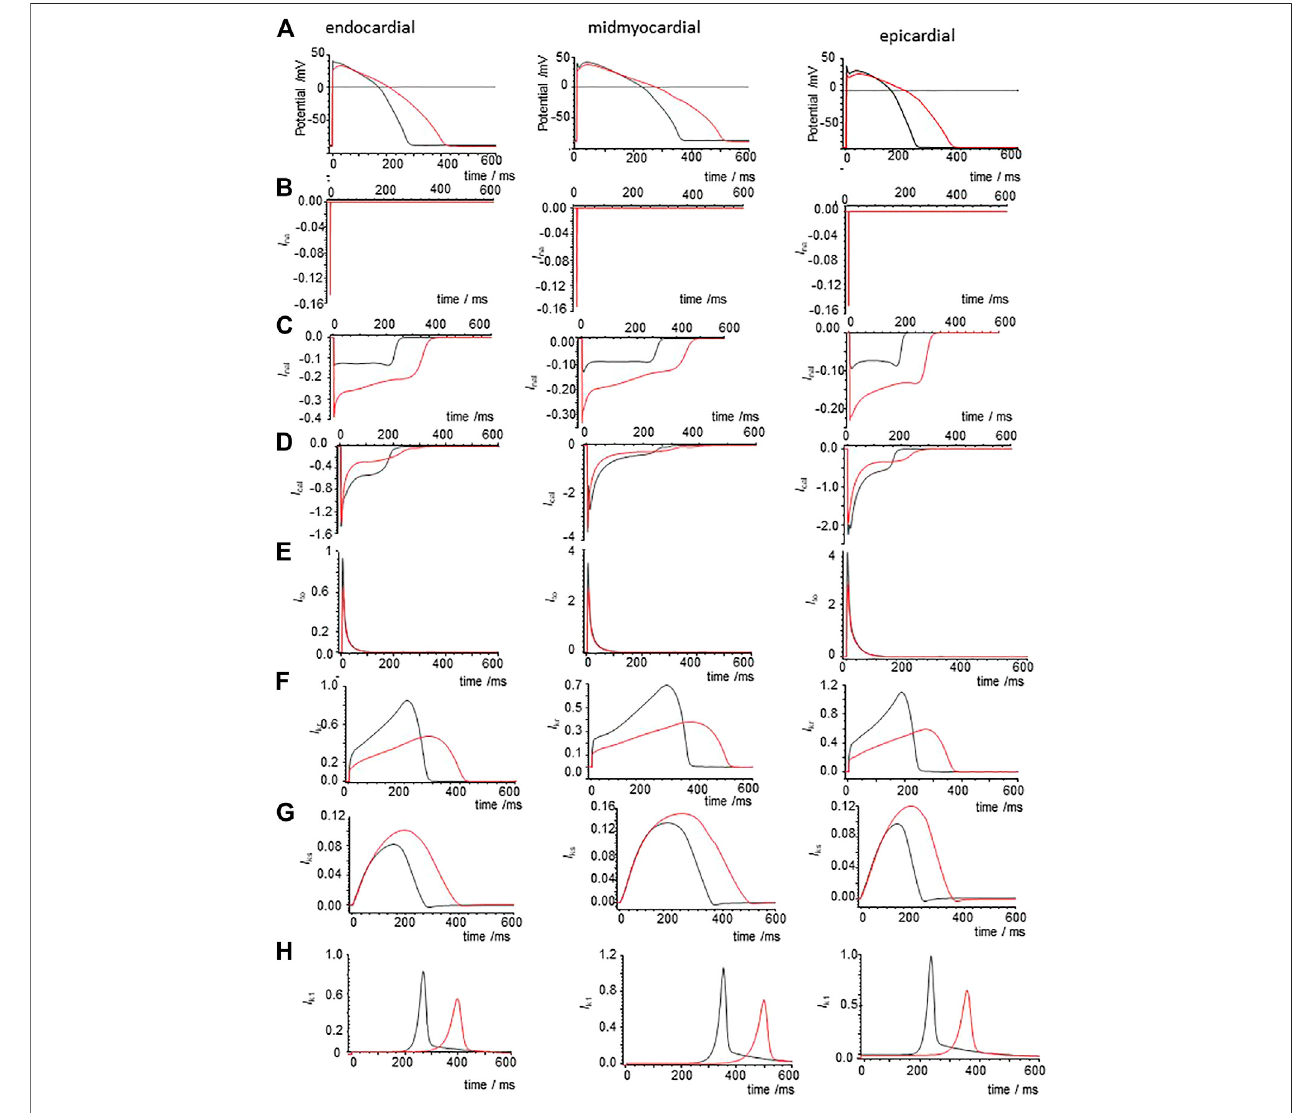
FIGURE 7 | Ionic currents underlying action potential prolongation by the effects of CO on action potentials in the un-diseased ORd cell models. (A) Action potentials of endo-, midmyo- and epi-cardial cell models. 100th action potential at BCL of 1 s (B) I Na , (C) I NaL , (D) I Ca,L , (E) I to , (F) I Kr , (G) I Ks , (H) I K1 during these action potentials, all currents in μ A/ μ F. Red: with CO parameters, black standard parameters.